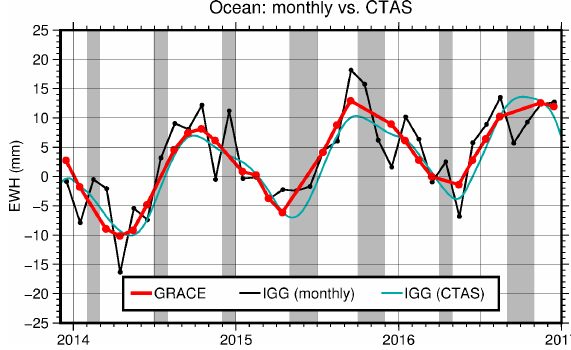
Figure 5. Effect of modeling of non-gravitational forces on ocean mass computation. IGG (mod.) is the monthly solution described in Table 3. The only difference in IGG (not mod.) is that non- gravitational accelerations were not modeled, but a constant value per arc was still co-estimated.